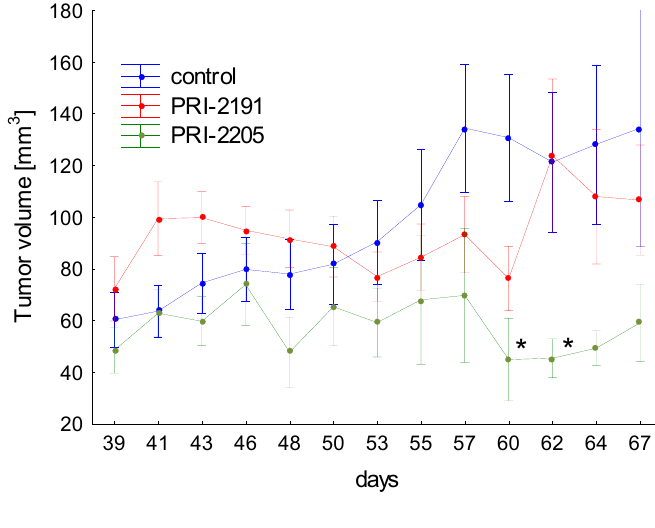
Figure 6. The kinetic of MCF-7 subcutaneous tumor growth. One day before cancer cells inoculation, 90-days release 17- β -estradiol pellets were subcutaneously (s.c.) inoculated. The treatment of NU/J mice bearing subcutaneous human breast MCF-7 tumors were started on day 39 after tumor cells inoculation. PRI-2191 or PRI-2205 were injected s.c. at doses of 1.0 μ g/kg/day or 10.0 μ g/kg/day, respectively, three times a week, up to day 67 (total dose of PRI-2191: 13 µg/kg; PRI-2205: 130 µg/kg). Means with standard error bars are presented. p < 0.05 as compared to control, Mann-Whitney U